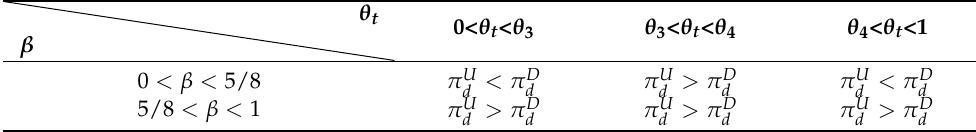
Table 7. The comparison of retail system’s profit between Scenario U and Scenario D. β